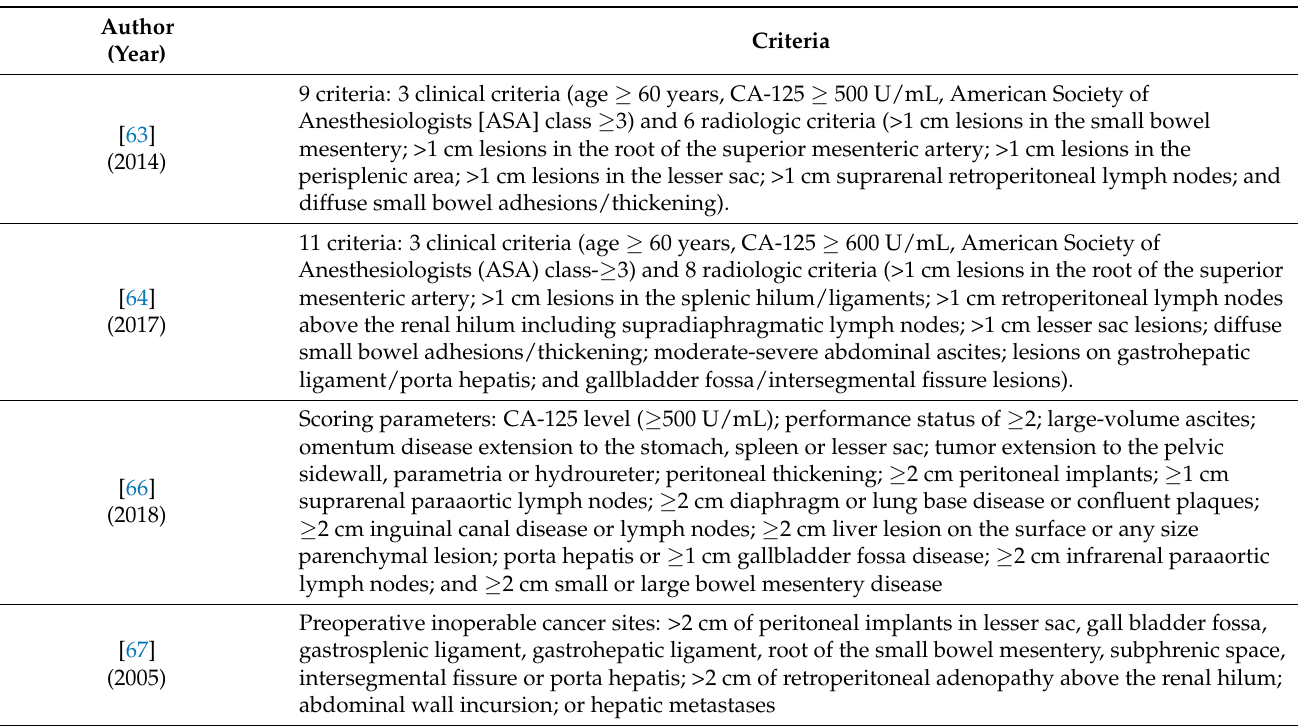
Table 4. Detailed criteria of models based on radiology